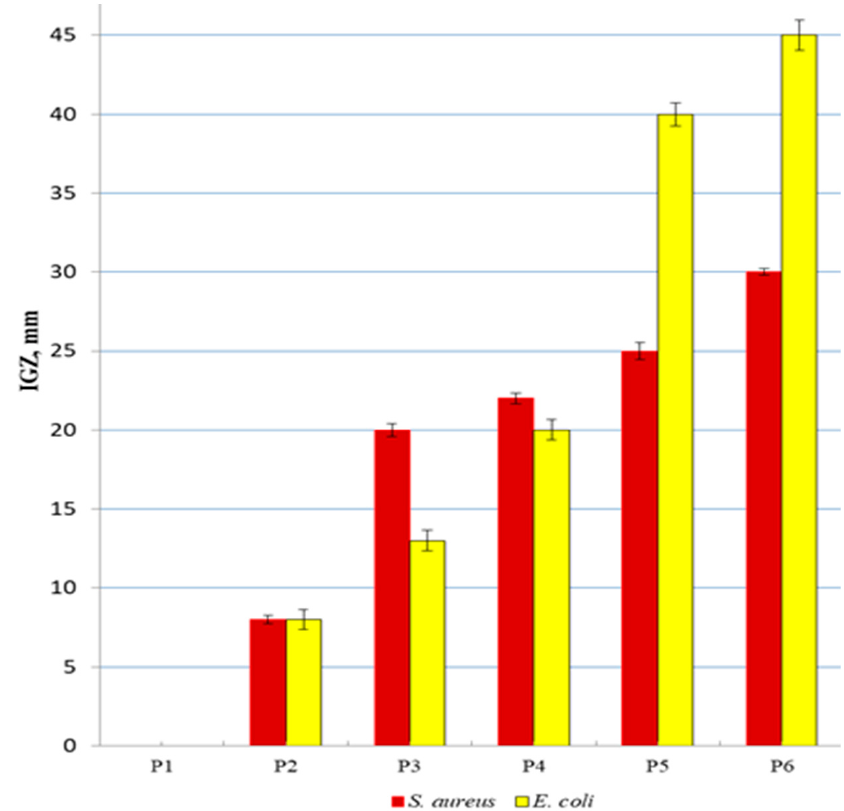
Figure 10. Antibacterial activity expressed as a diameter of the inhibition growth zone (IGZ) against Staphylococcus aureus ATTC 2592 and Escherichia coli ATCC 8738.